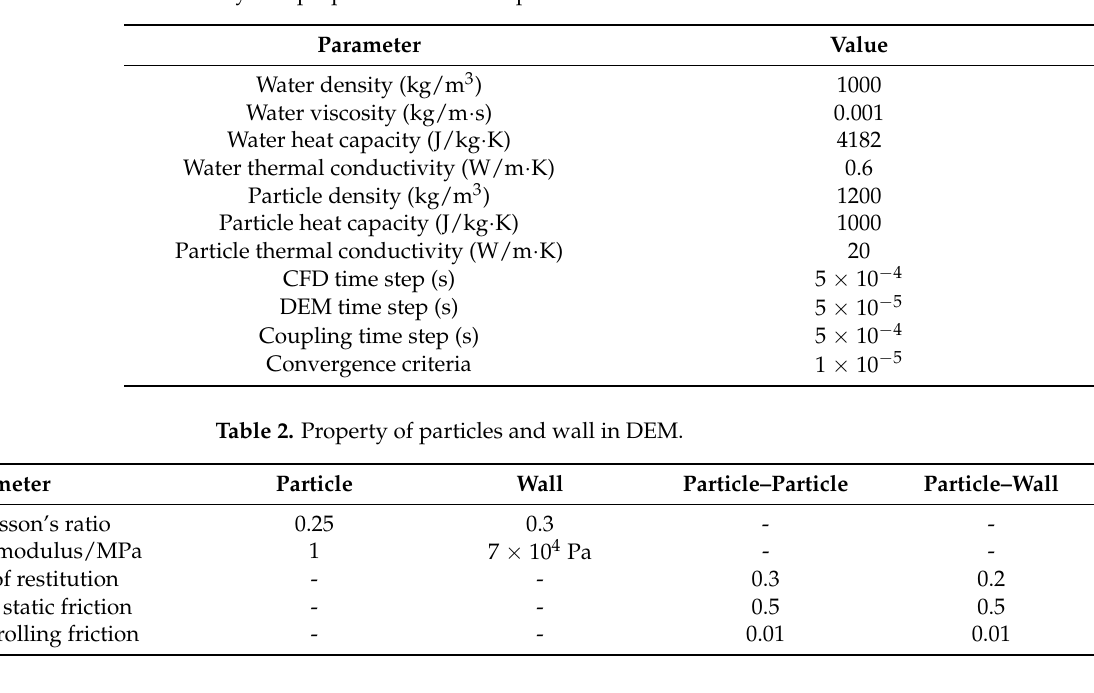
Table 1. Physical properties and model parameters.